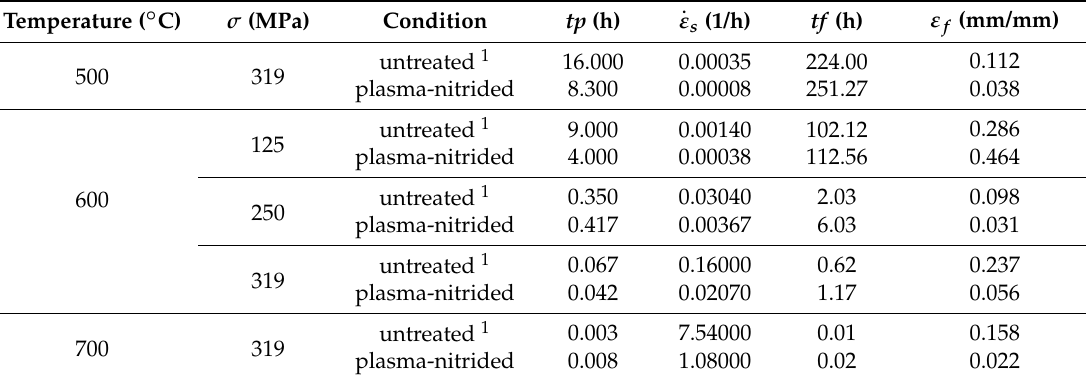
Table 3. Creep data of the plasma-nitrided Ti-6Al-4V with Widmanstätten microstructure to untreated condition, data from Briguente [33].